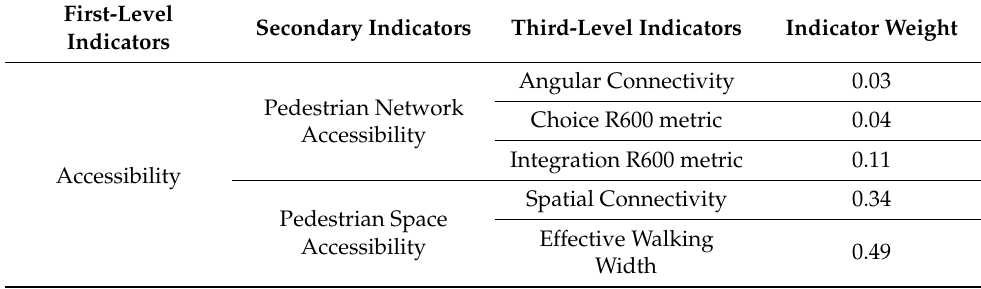
Table 2. Weights of pedestrian accessibility indicators of children’s school travel roads.